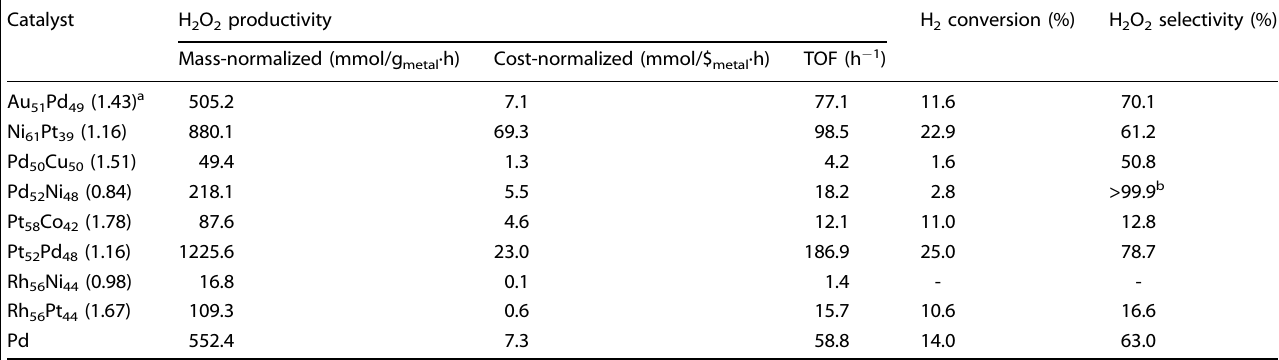
Table 1. Catalytic performances of eight bimetallic NPs proposed by the DFT screening process in comparison with that of pure Pd NPs. Catalyst H 2 O 2 productivity H 2 conversion